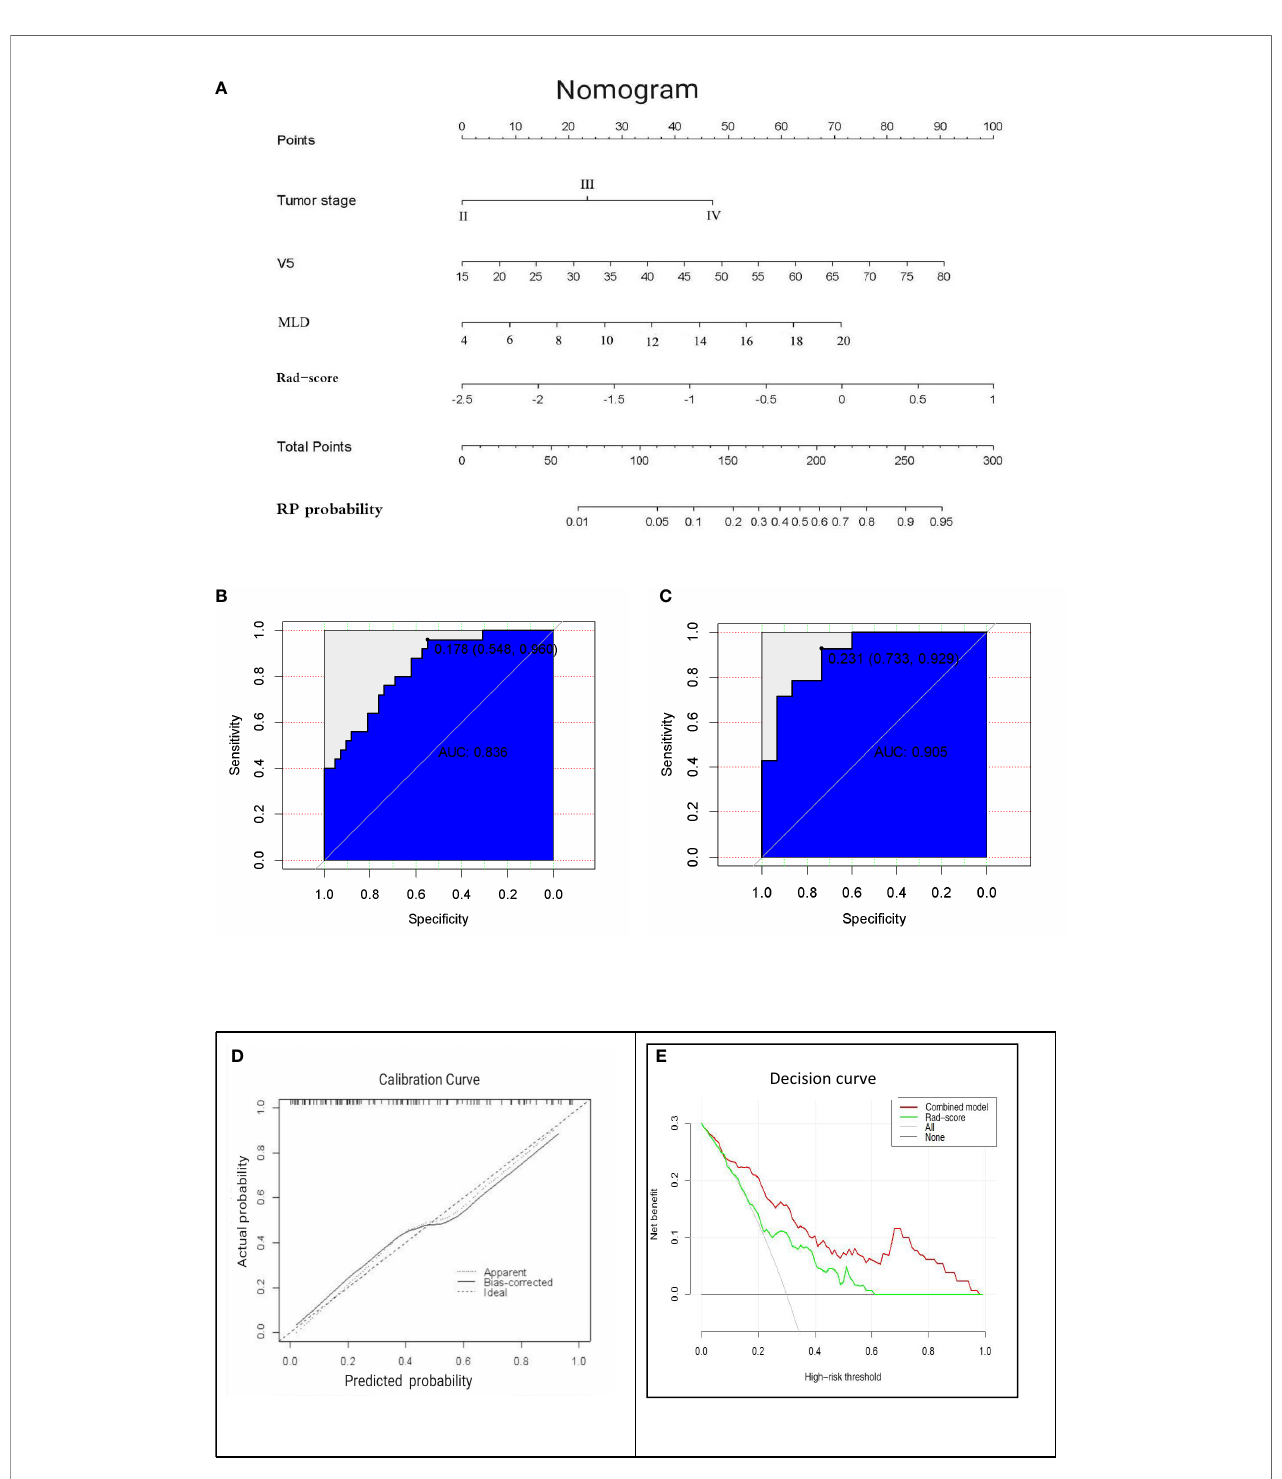
FIGURE 6 | (A) The comprehensive nomogram incorporates V5, MLD, tumor stage, and rad-score (the fi rst period) to predict the risk of RP in EC patients. V5: relative volume of total lung treated with ≥ 5 Gy; MLD: mean lung dose. (B, C) ROC curves of the comprehensive nomogram in the primary and validation cohorts. (D) Calibration curves of the comprehensive nomogram with the addition of V5, MLD, tumor stage, and radiomics features. The diagonal dotted line represents an ideal evaluation, and the other two lines next to it represent the performance of the nomogram. A closer fi t to the diagonal dotted line indicates a better evaluation. (E) Decision curves of the radiomics features model and the combination model (comprehensive nomogram) predicting RP. The y -axis represents the net bene fi t. The red curve represents the comprehensive nomogram, and the green line represents the radiomics features model. The horizontal black line indicates that the assumption is valid. The oblique gray line indicates that the assumption is